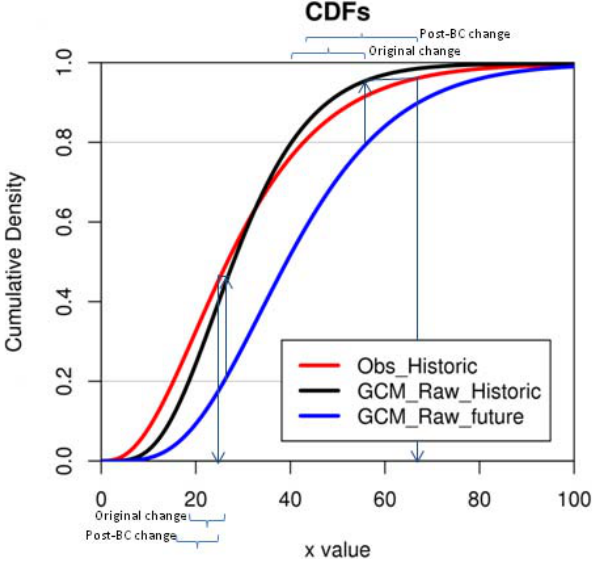
Fig. 1. Cumulative distribution functions for a synthetic demonstra- tion set of observed, GCM simulated historic, and GCM projected future precipitation data.